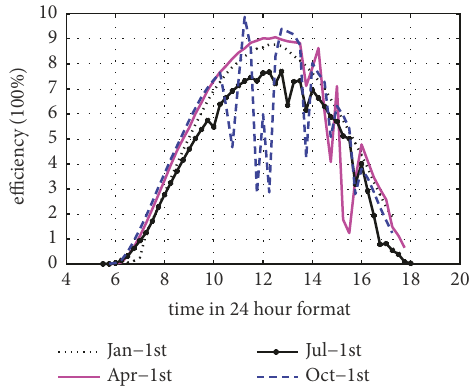
Figure 15: Hourly variation of efficiency of Kyocera 200GT PV module for 2 Ω resistance.